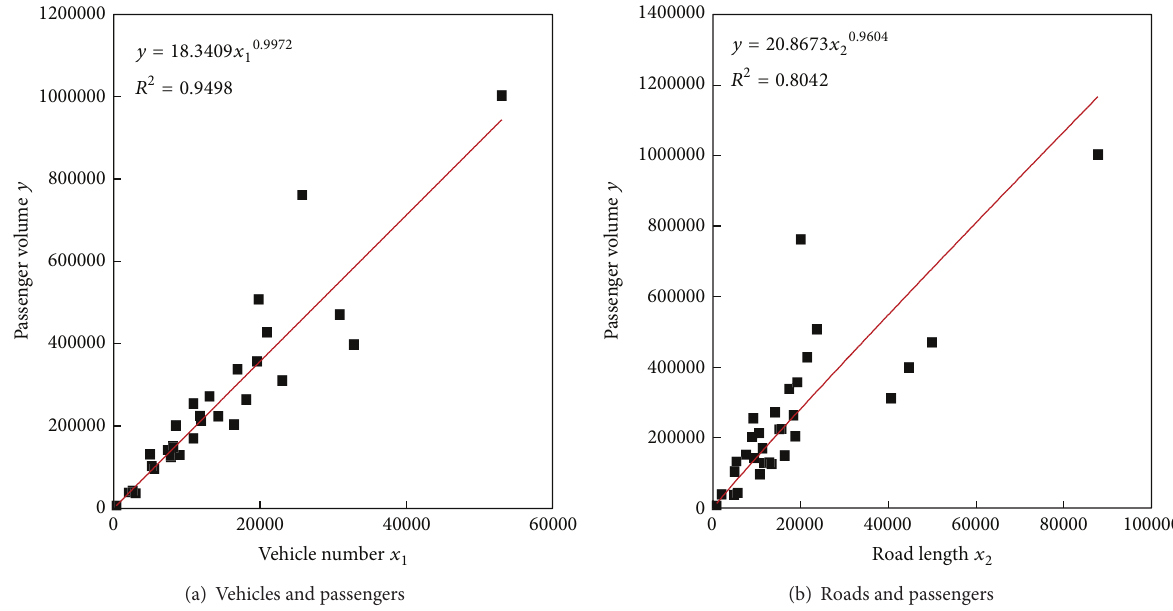
Figure 2: The allometric scaling relations between vehicles/roads and passengers: global modeling of the urban public transportation of China